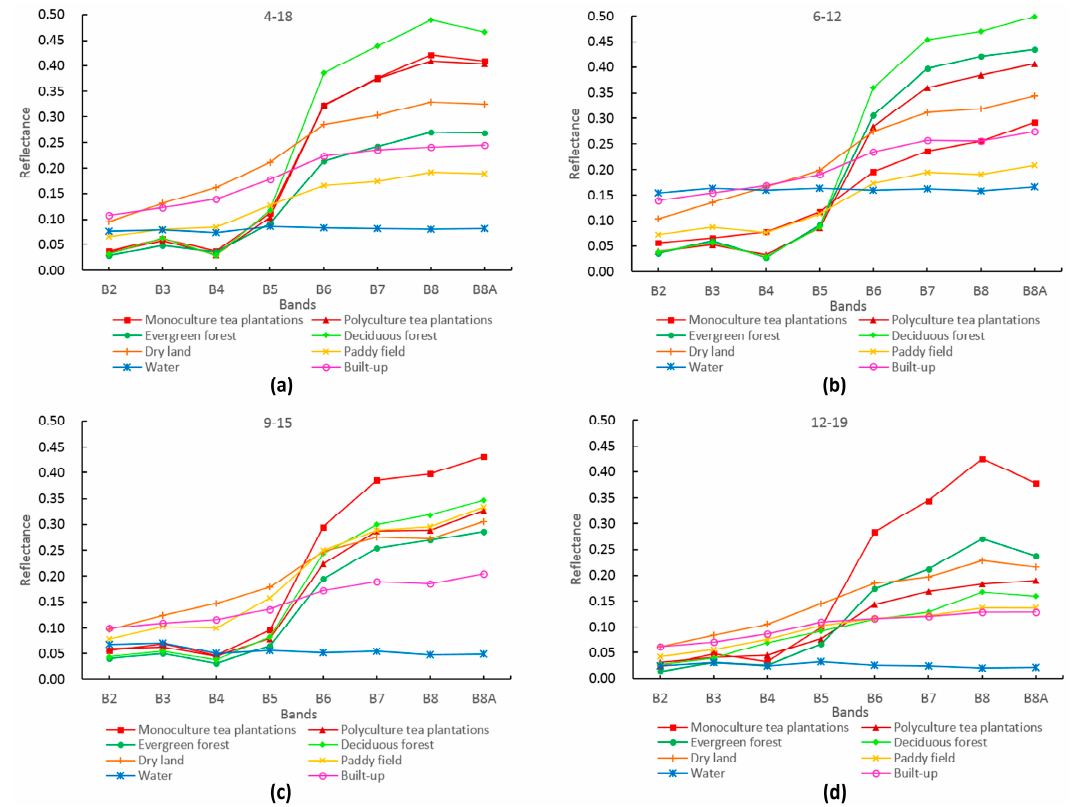
Figure 6. Spectral curves of the eight LULC types in the study area on ( a ) 18 April 2018, ( b ) 12 June 2018, ( c ) 15 September 2017, and ( d ) 19 December 2017.